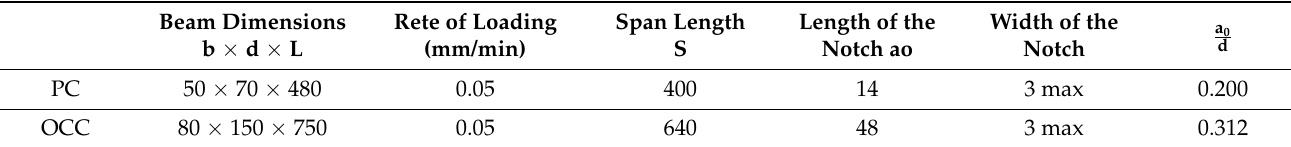
Table 3. Dimensions of sample and central notch properties.